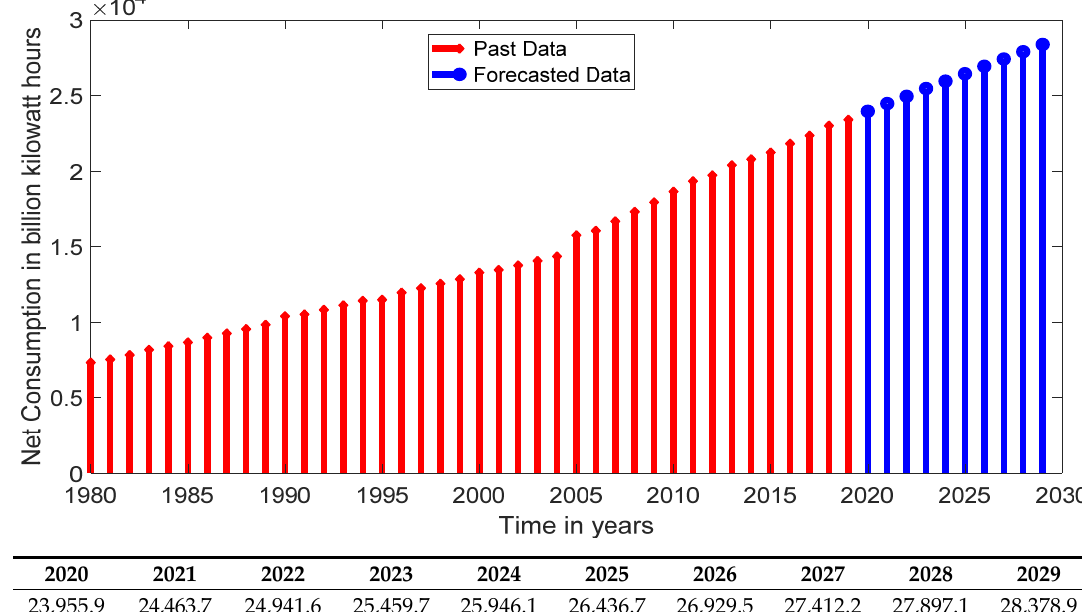
Figure 8. The anticipated figures for the forthcoming decade of the aforementioned dataset. Based on the statistics illustrated in the figure, the evolution ratio of the electric energy consumption numbers exhibits a linearly expanding